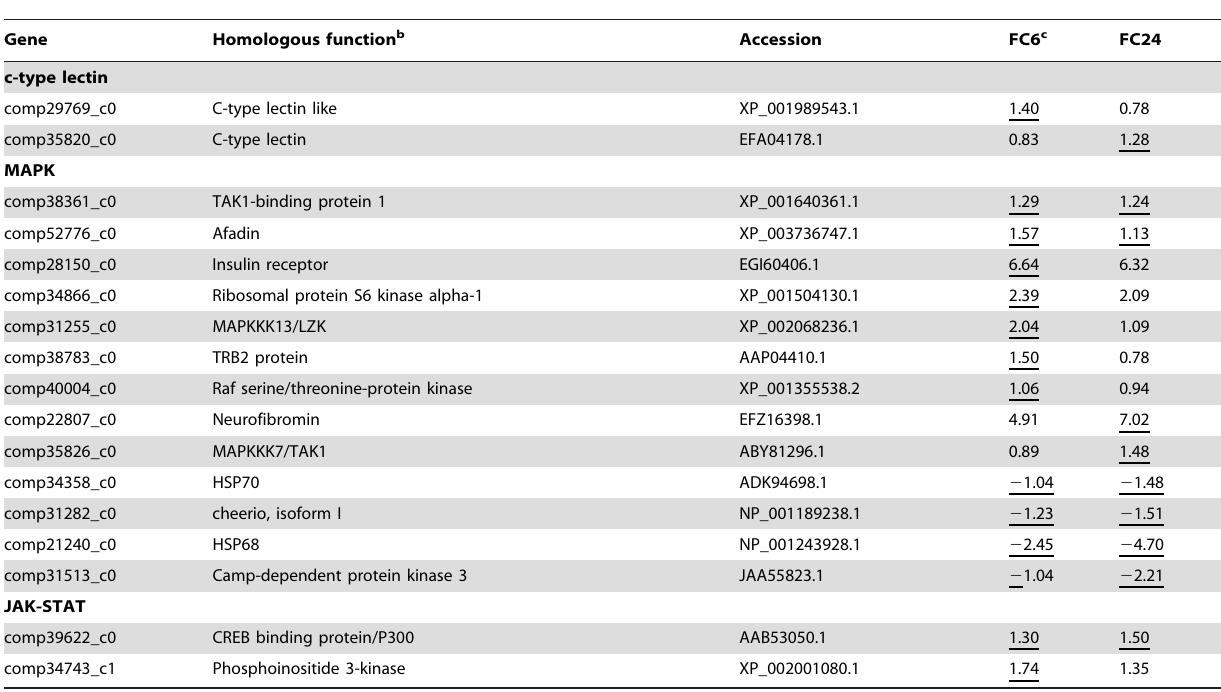
Table 1. Genes involved in immune related signaling a .